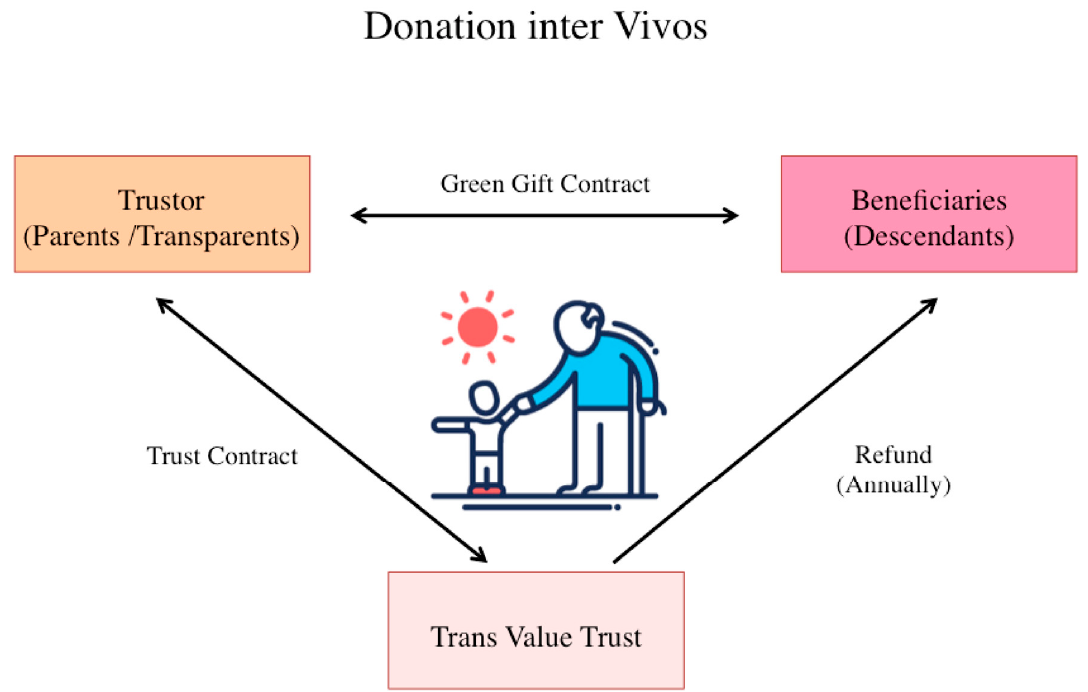
Figure 7. Under the Green Gift Contract, the trustors have to designate their descendants to accept the ‘green gift’. Source: modified from Prefecture-Shiga (2017).